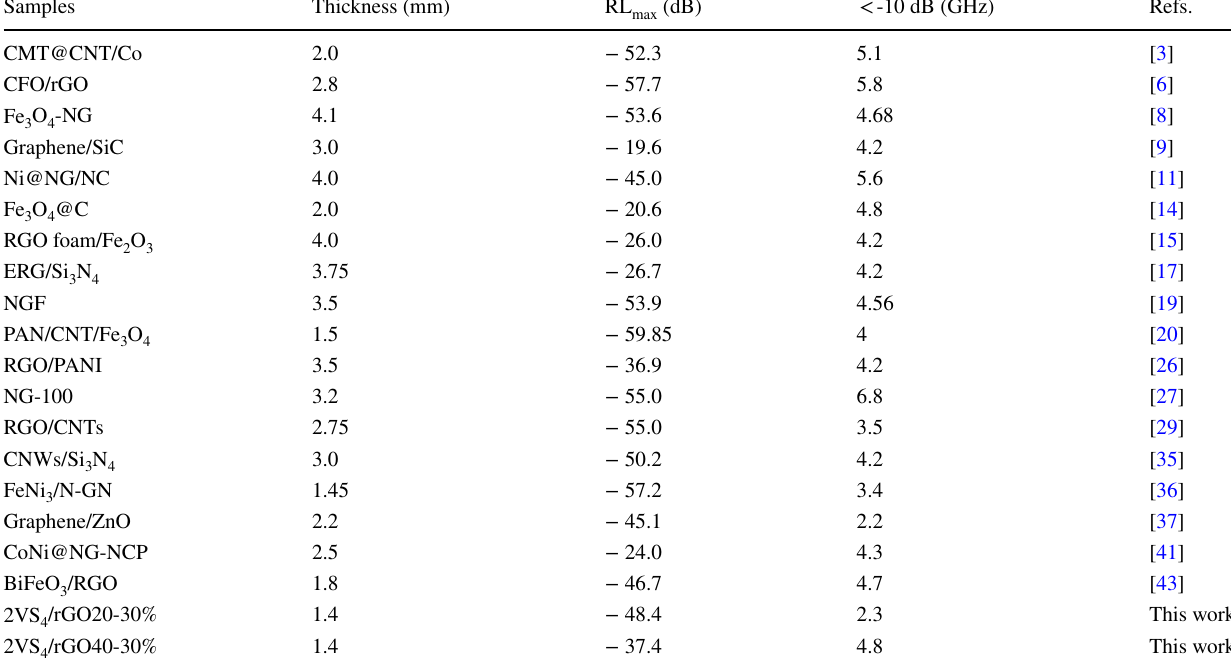
Table 1 Typical graphene-based heterostructure and their microwave absorption performance